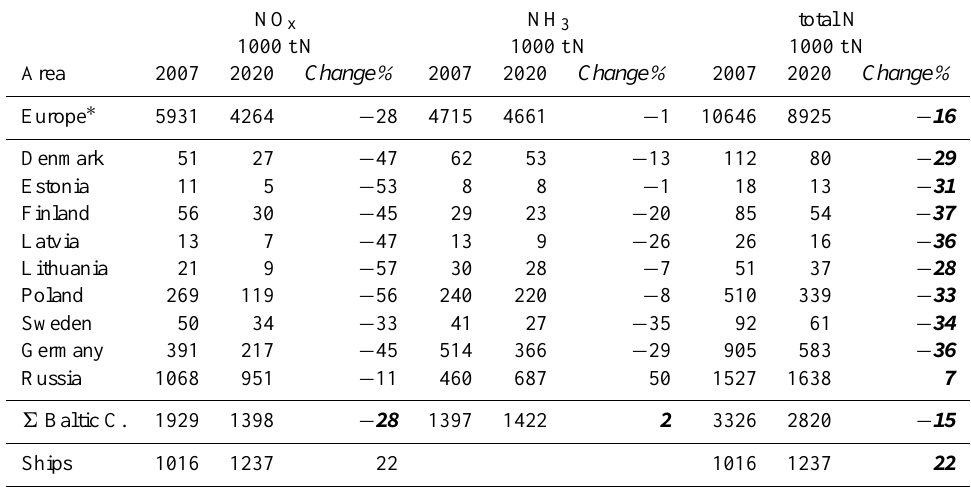
Table 1. The applied emissions of NO x , NH 3 and total nitrogen for 2007 and 2020 given for Europe (emissions within the European model domain), the countries with coastlines to the Baltic Sea ( P Baltic C.) and from ship traffic in